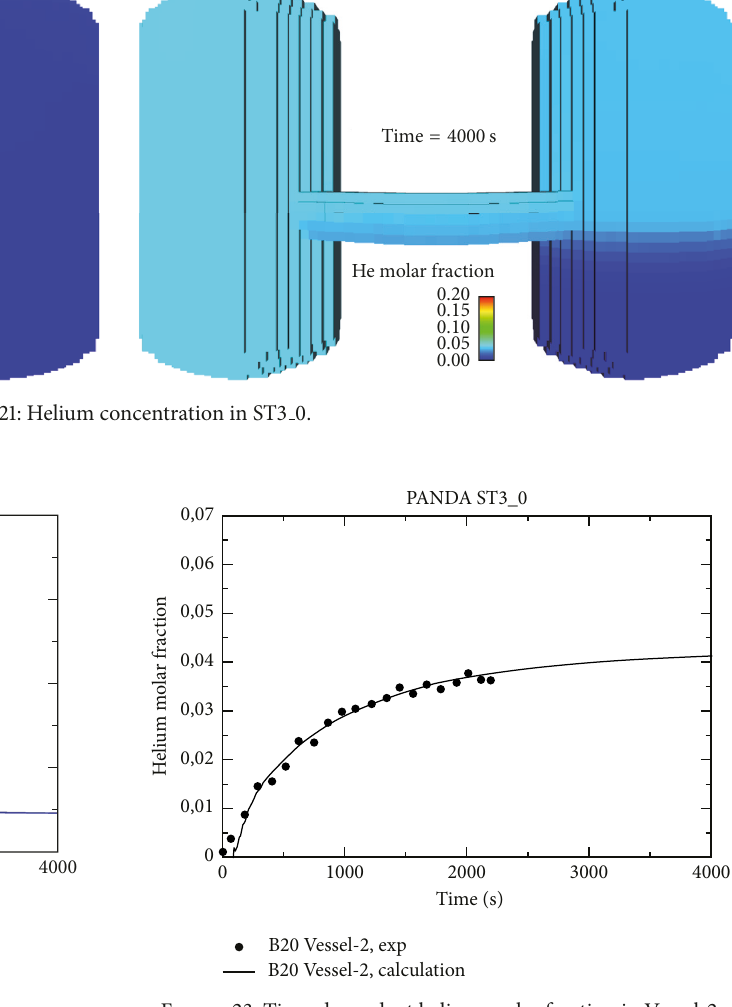
Figure 23: Time-dependent helium molar fraction in